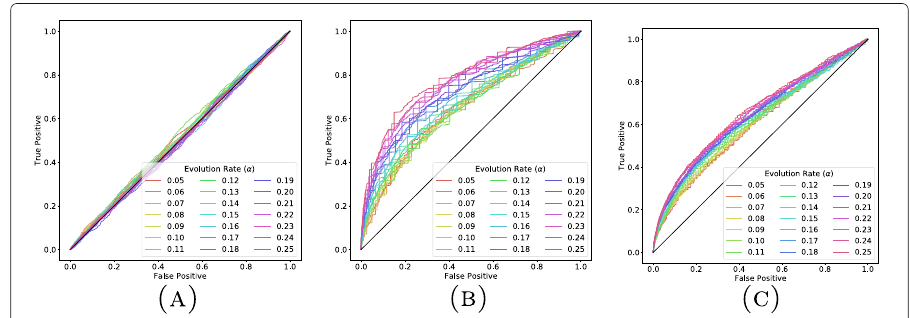
Fig. 7 Bump Power-Law, Lateral Movement, 10 edges. a Kolmogorov-Smirnov. b Relative Hausdorff. c